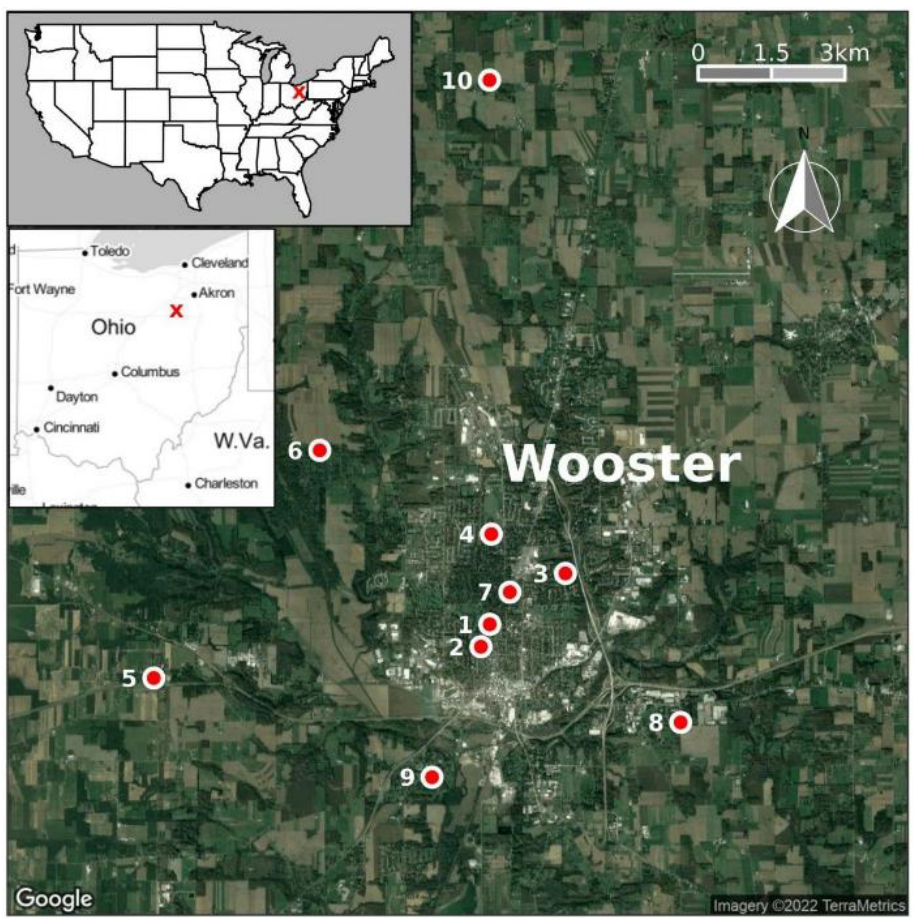
Figure 1. Location of Wooster, Northeastern Ohio, USA, and collection sites. W. Va stands for West Virginia.